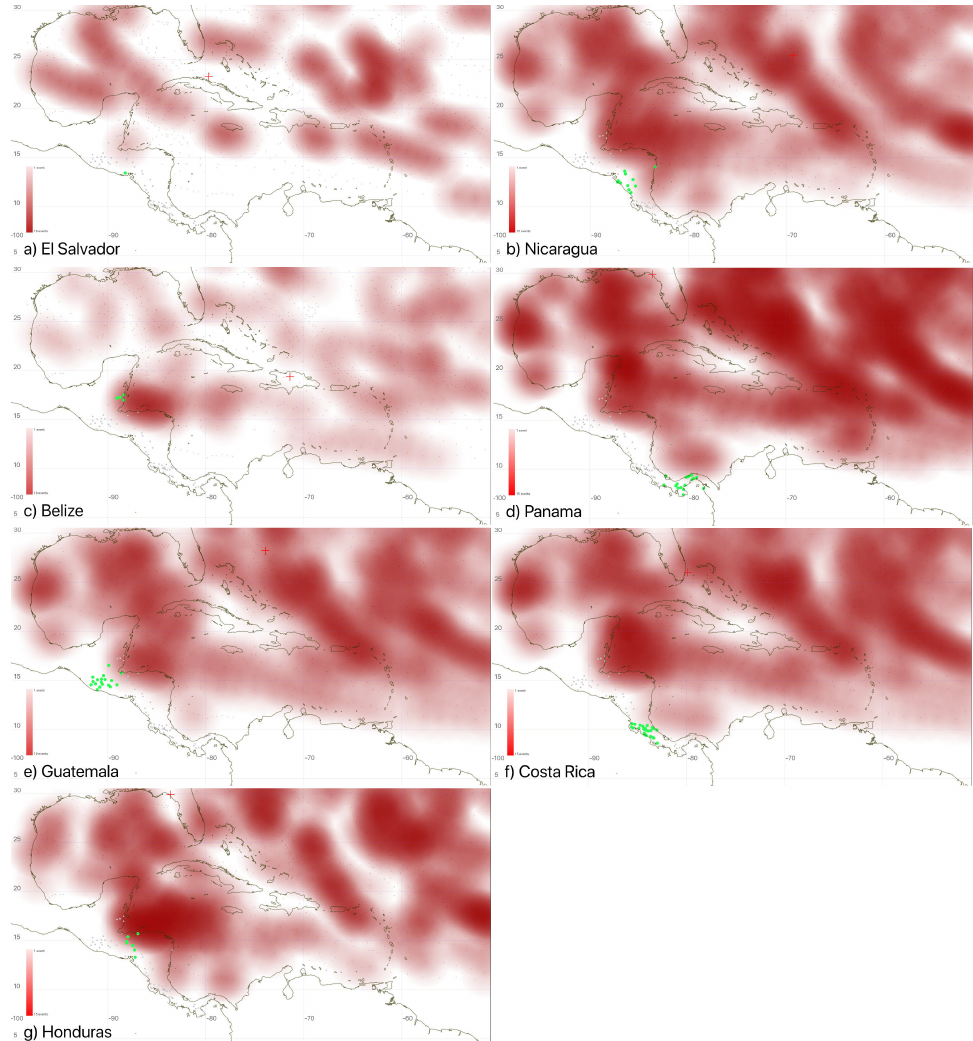
Figure 1. Densities of Caribbean tropical cyclones trajectories that produce extreme precipitation events in countries of Central America (data 1970–2010). The shades are shown with an arbitrary intensity scale (only their relative spatial pattern is of interest within each of the maps). The scale of the shading represents the density of red color shades of the intersection from 1 to 15 trajectories. Gray dots are the location of the inactive stations, light green dots are the stations active in the tool that are associated with the red cyclone densities shadings. The subfigures correspond to the densities of tropical cyclones trajectories associated with extreme precipitation events in the meteorological stations of the different Central America countries shown with green dots in the figure. The subfigures are shown for El Salvador ( a ), Nicaragua ( b ), Belize ( c ), Panama ( d ), Guatemala ( e ), Costa Rica ( f ) and Honduras ( g ). Data